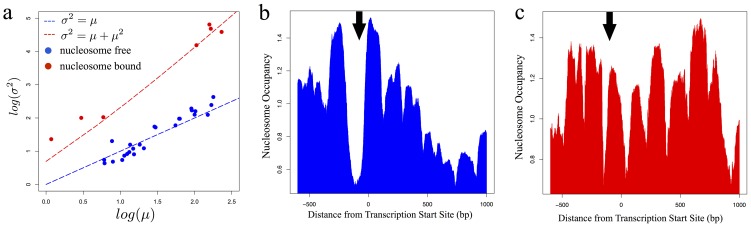
Analysis of mRNA distributions connects underlying promoter kinetics to nucleosome occupancy.a) mRNA mean and variance in S. cerevisiae plotted against each other in log-scale. Blue dashed line indicates the expected relationship between mean and variance in a regime of slow activation and fast inactivation rate (σ2 = μ), red dashed line indicates expected relationship at slow promoter kinetics (σ2 = μ+μ2). Circles represent experimental values of mRNA mean and variance (color matches best fit to promoter kinetics regime) b) Average nucleosome occupancy between −600 to +1000 relative to the TSS of S. cerevisiae genes exhibiting linear mRNA mean-variance scaling. The position of the canonical nucleosome free region is indicated by the black arrow. c) Same as b) but with respect to S. cerevisiae genes exhibiting quadratic mRNA mean-variance scaling.